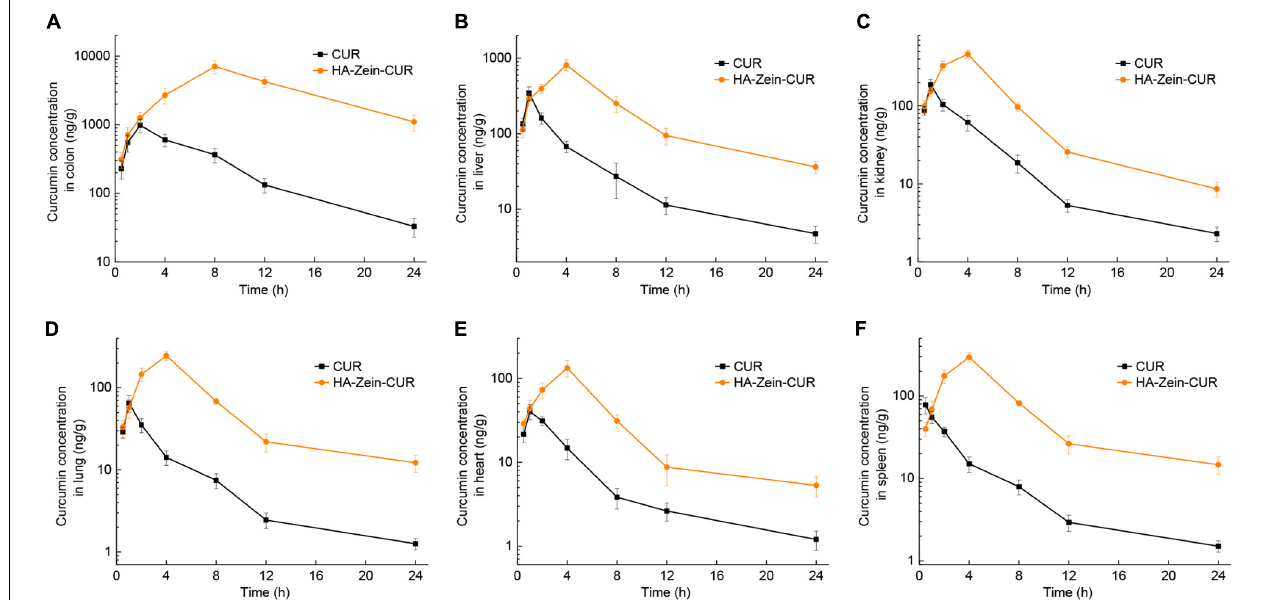
FIGURE 7 | Organ distribution of CUR in mice. Concentration profile of CUR in panel (A) colon, (B) liver, (C) kidney, (D) lung, (E) heart, and (F) spleen following intragastric administration of free CUR and HA-Zein-CUR, respectively. Values are mean ± SD, n = 3.